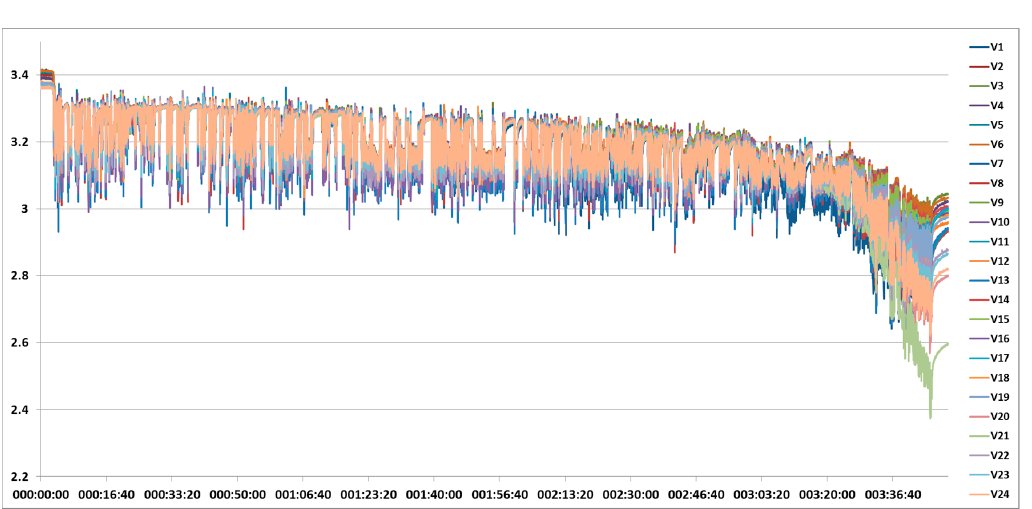
Figure 9. Results of the two-staged charging method.